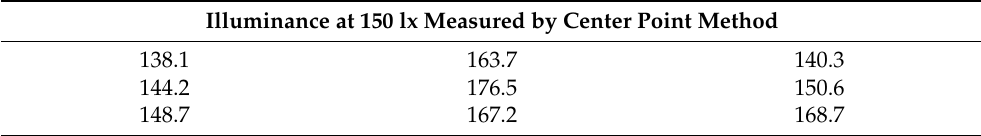
Table 3. Illuminance at 150 lx measured using the center point method.